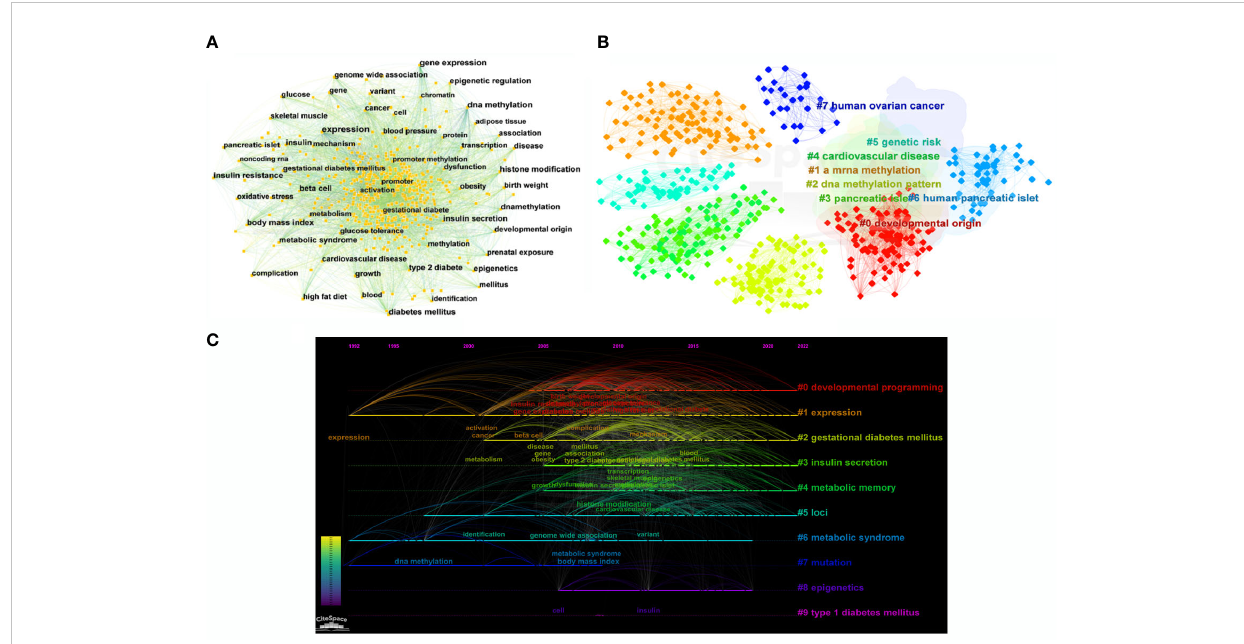
FIGURE 7 Bibliographic analysis of keywords. (A) Visualization of keywords. Each node denotes the keywords. (B) A clustering map of keywords. Colorful areas with the nodes represent the keyword clusters. (C) A timeline view of keywords. The horizontal line with different colored labels denotes the cluster formed by the keyword, and the position of the node on the line represents the year in which the publication containing the keyword fi rst appeared.